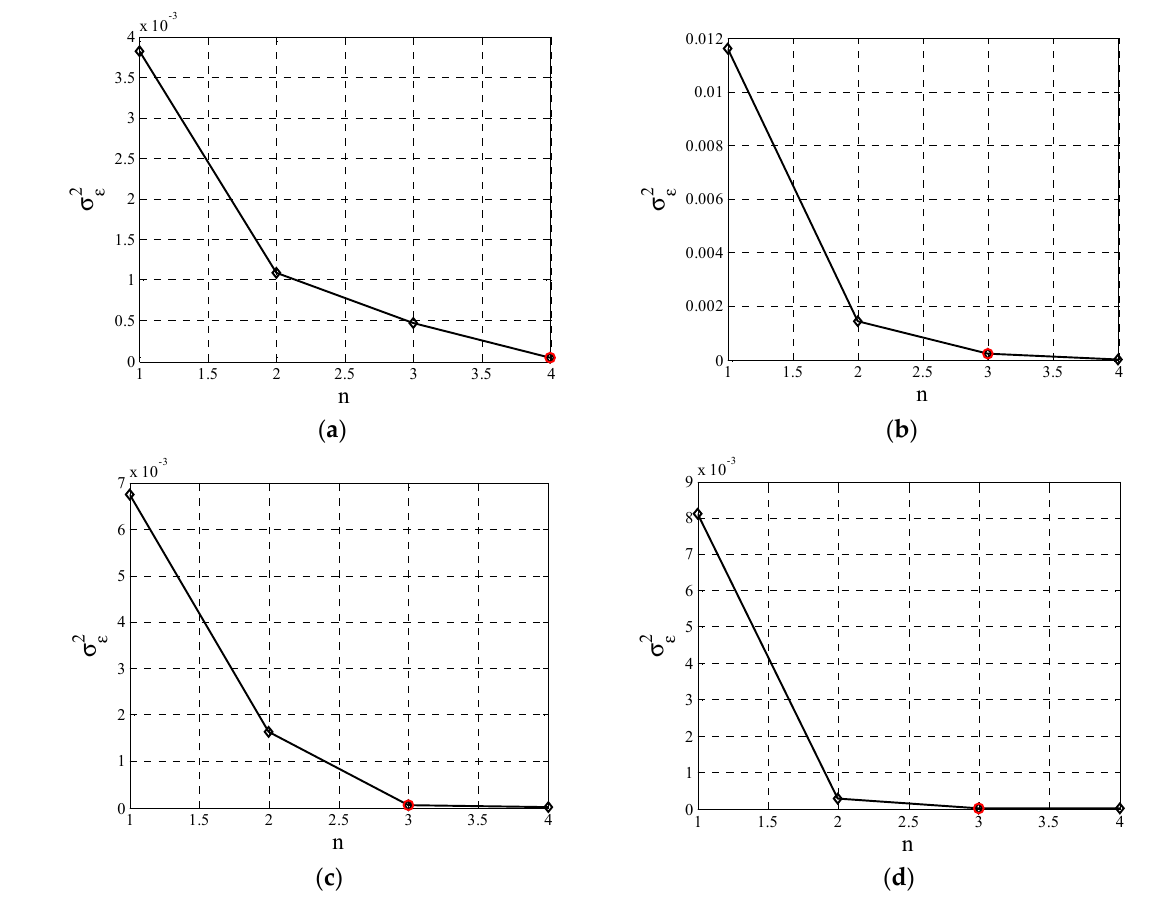
Figure 6. The dependence of criterion (13) on the order n of the ARMA model describing the flow rate of flotation feed solids, determined for a series of measurement data: ( a ) y 1 , ( b ) y 2 , ( c ) y 3 , ( d ) y 4 based on the residuals described by the model of order p = 5. Table 3. Parameters of third-order ARMA models estimated for successive series of measured data.